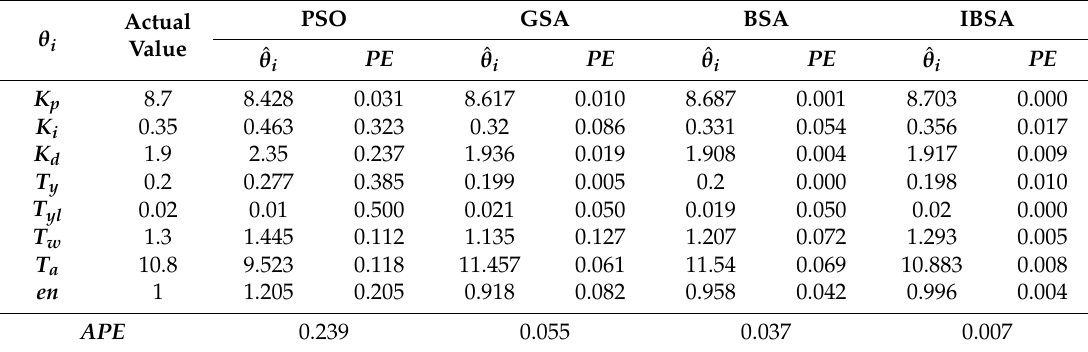
Table 1. Parameter identification error of the four algorithms under frequency